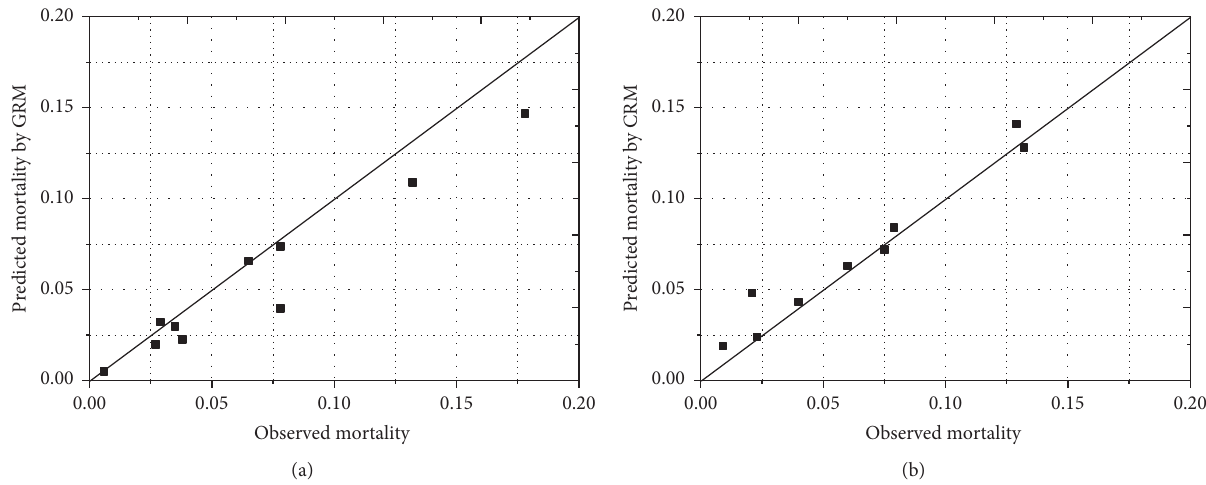
Figure 3: Predicted and observed mortality by deciles of predicted mortality. GRM: GRACE risk model; CRM: CAMI-NSTEMI risk